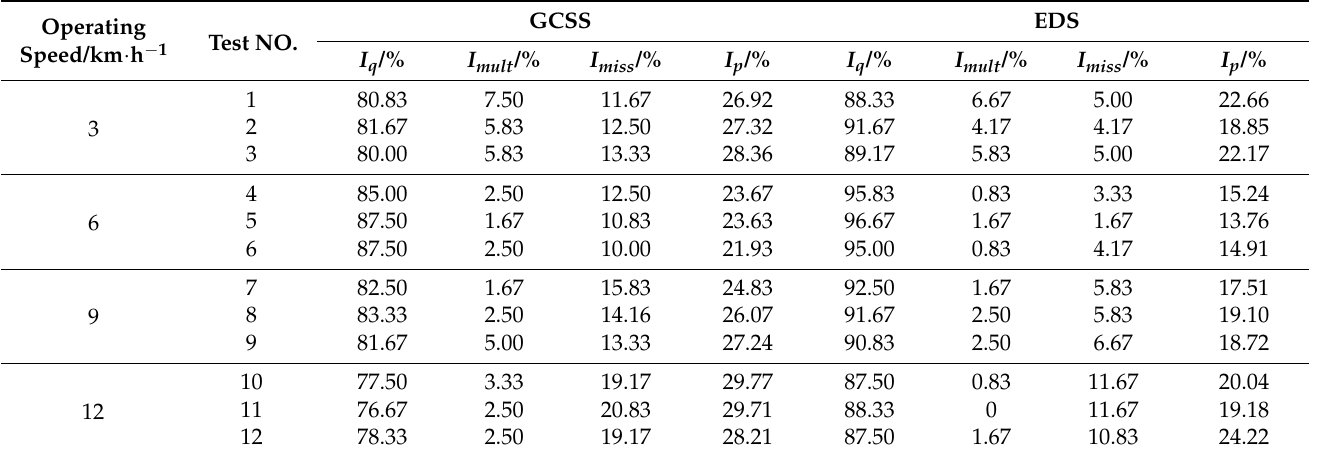
Table 5. Statistical results of seeding performance of two seeding methods at different operating speeds.